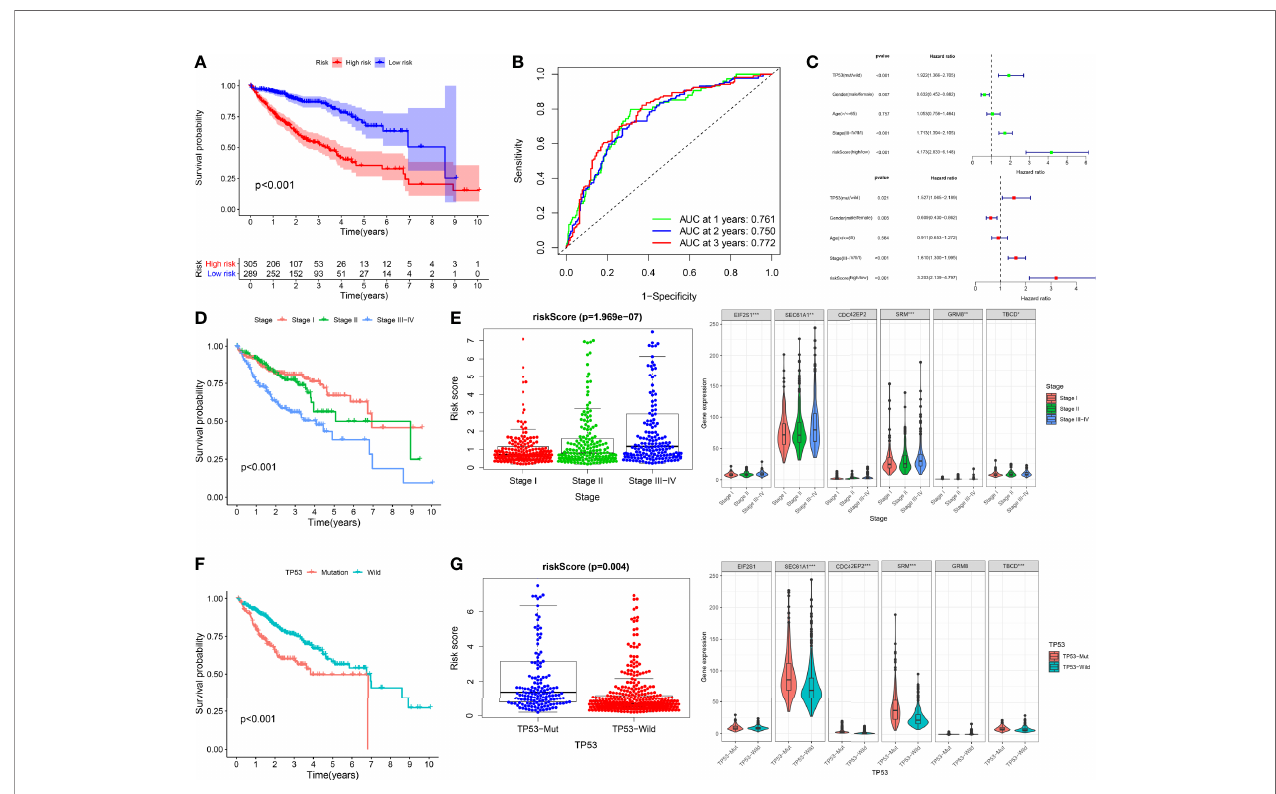
FIGURE 9 | Integrated analysis of the prognostic signature in whole cohort (A – C) The Kaplan – Meier survival analysis, time − dependent ROC analysis, and independence analysis of the signature for predicting the overall survival of patients in the whole cohort(n=594) (green represents univariate analysis, and red represents multivariate analysis) (D, E) The relationship between the risk score and TNM-stage (F, G) The relationship between the risk score and TP53. ***p < 0.001; **p < 0.01; *p <